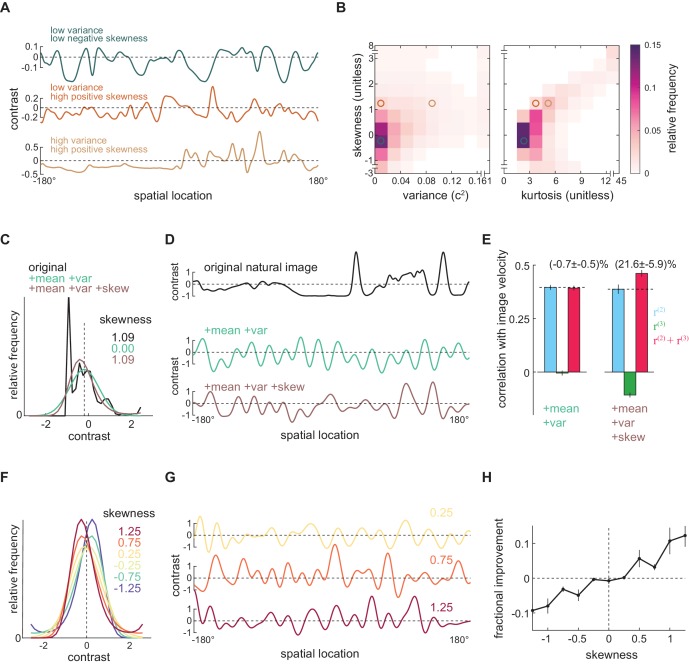
Positive skewness is sufficient for the third-order kernel to improve motion estimation.(A) Three example natural scenes with different degrees of variance and skewness. (B) Joint-density maps of individual image statistics over the ensemble of natural images, showing the relationship between skewness and variance (left) and skewness and kurtosis (right). (C) Contrast distributions of example images from the natural scene dataset and two synthetic image datasets. The natural image is shown (black), along with a maximum entropy distribution (MED) with matched mean and variance, denoted by +mean +var (green) and an MED with matched mean, variance, and skewness, denoted by +mean +var +skew (brown). (D) Example images from the natural scene dataset and two synthetic image datasets corresponding to three contrast distributions in (C). (E) The Pearson correlation coefficient between true image velocities and each kernel’s responses in the two synthetic datasets +mean +var (green) and +mean +var +skew (brown) (F) Example of MEDs in six synthetic datasets, in which the image skewness ranged from −1.25 to 1.25. (G) Example of synthetic images in three synthetic datasets, corresponding to MEDs in (F) with constrained skewness of 0.25 (top), 0.75 (middle), and 1.25 (bottom). (H) Improvement added by the third-order response as a function of synthetic image skewness.